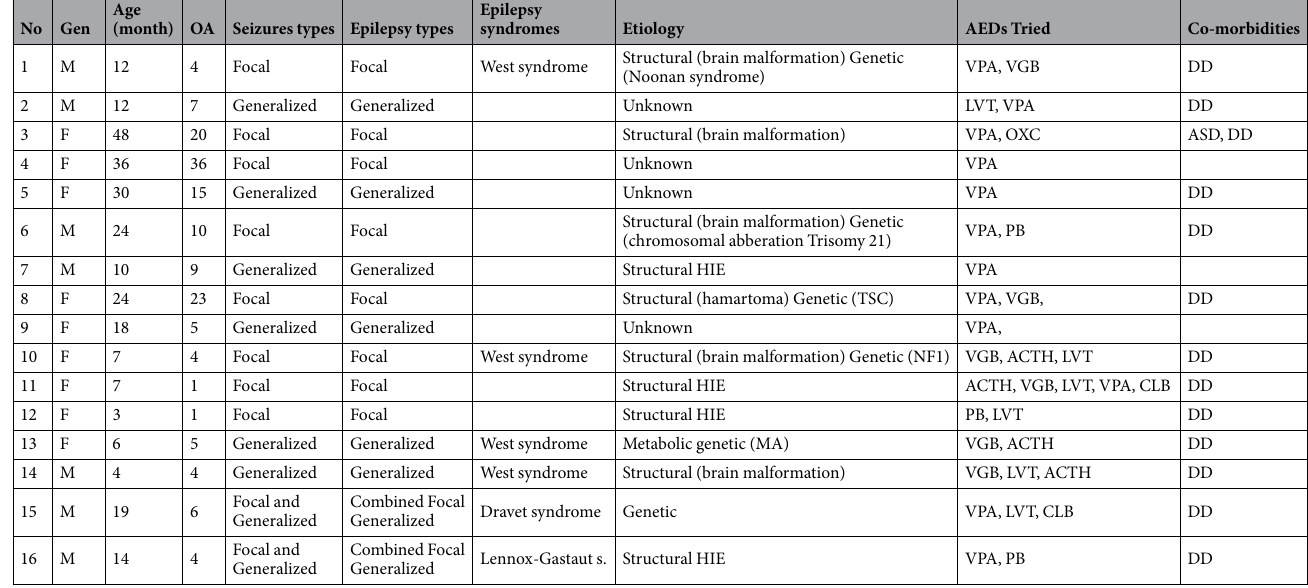
Table 2. Clinical characteristics of epilepsy group (EG 2 ) without seizures. Abbreviation: No – patient number; Gen – gender: male/female (M/F); Age - age at investigation; OA - age of epilepsy onset; HIE -